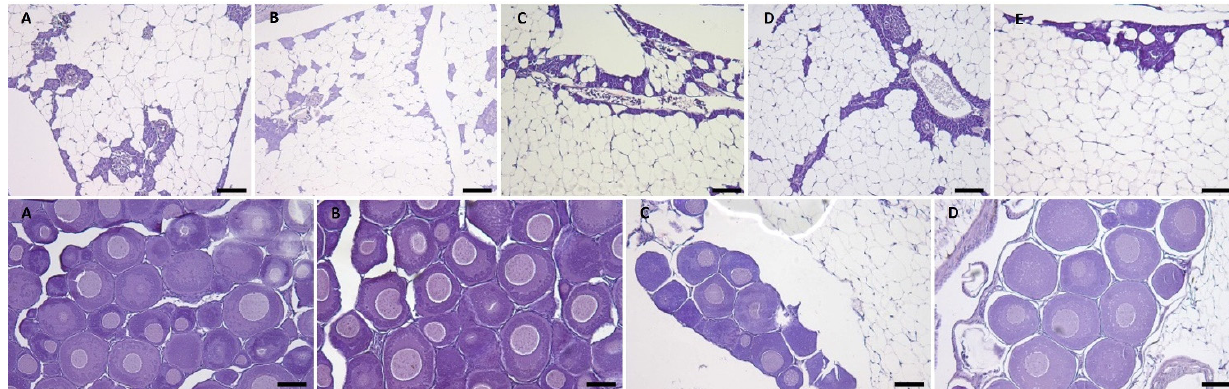
Figure 14. Pancreas and adipose tissue (visceral fat) ( first line ) and gonad ( second line ) of salmon at different sampling times. ( A ) Control. ( B ) 1 week after exposure. ( C ) 2 weeks after exposure. ( D ) 3 weeks after exposure. ( E ) 4 weeks after exposure. Scale bar: 100 µm.